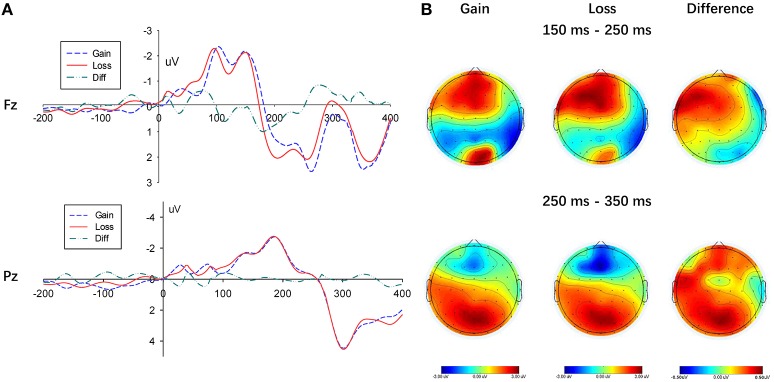
Results of the gain and loss conditions. (A) Representative example: ERP waveform in Fz and Pz; (B) topographic maps for P200 (150 ms-250 ms), N2 (250 ms-350 ms) and P300 (250 ms-350 ms).